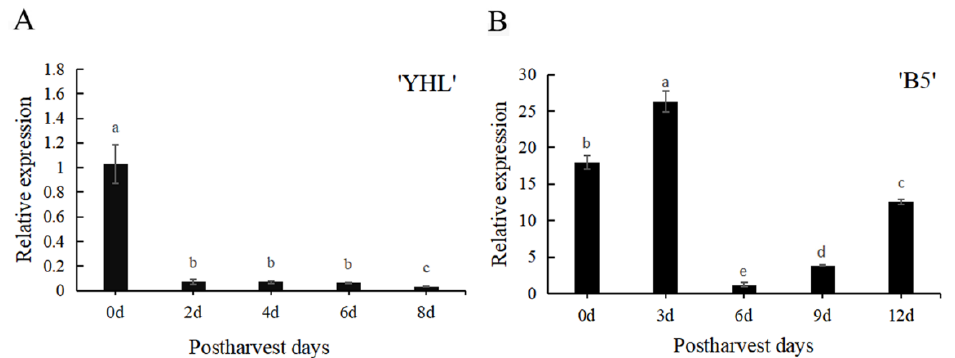
Figure 2. Expression level of PpSAUR43 of ‘YHL’ and ‘B5’ in the post-ripening stage. ( A ) Expression level of PpSAUR43 of ‘YHL’. ( B ) Expression level of PpSAUR43 of ‘B5’. The fruits were stored at 25.0 ± 1 °C after harvesting. Three biological replicates were used and each repetition was carried out by mixing flesh samples from three fruits. The expression of PpSAUR43 in ‘YHL’ at day 0 was used as the standard for normalization. Duncan’s test was used with the expression of PpSAUR43 at day 0 as a control, with different letters indicating significant differences ( p < 0.05).